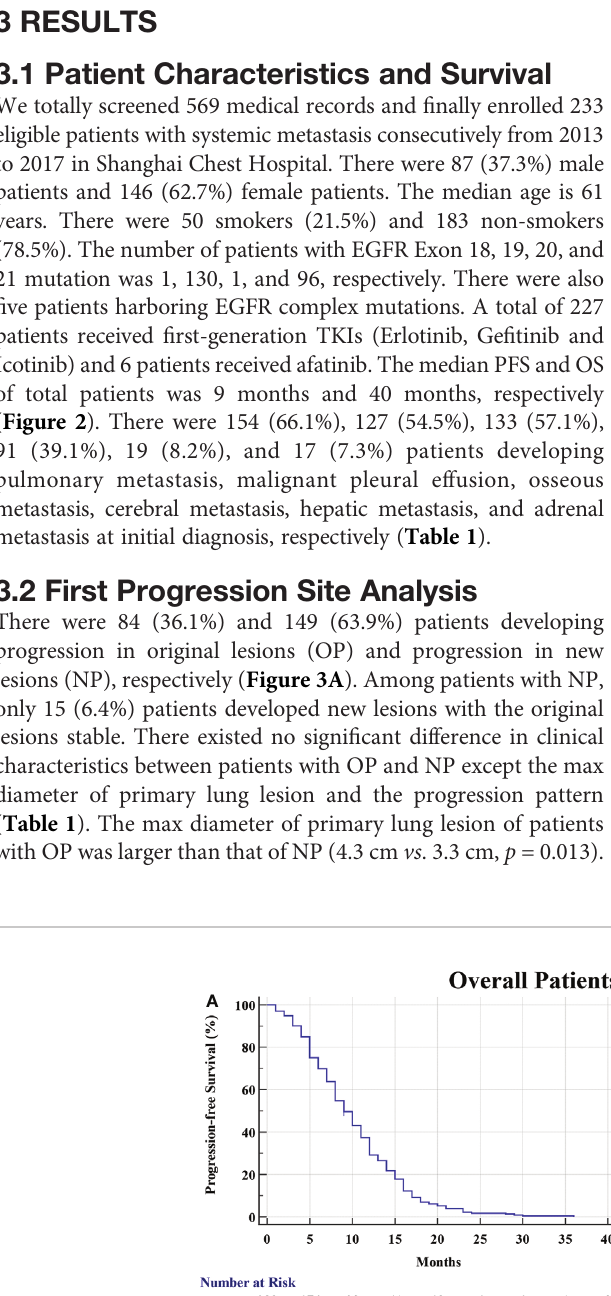
FIGURE 2 | (A) The PFS of overall patients was 9 months. (B) The OS of overall patients was 40